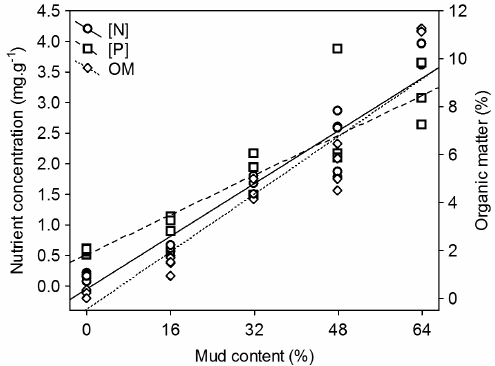
Figure 1. Relationships between mud concentrations and N, P and organic matter (OM) in sediment used in the